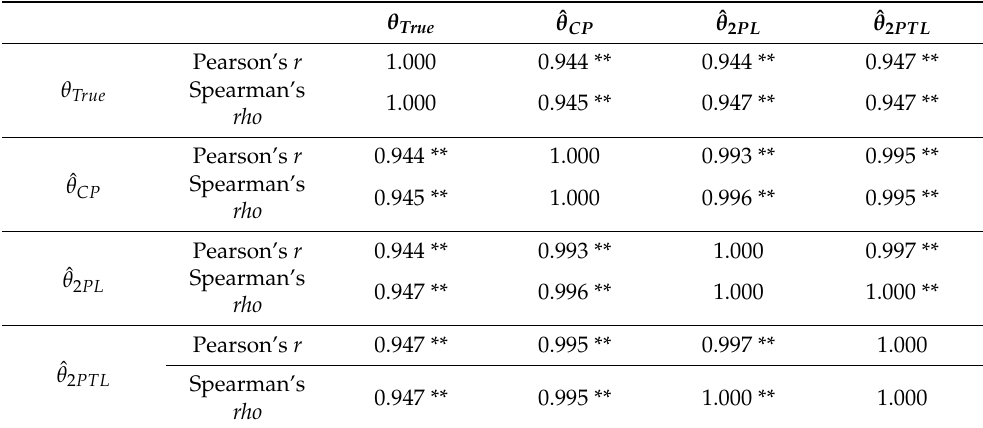
Table 4. Correlation Table of the Simulation Data Person Parameter